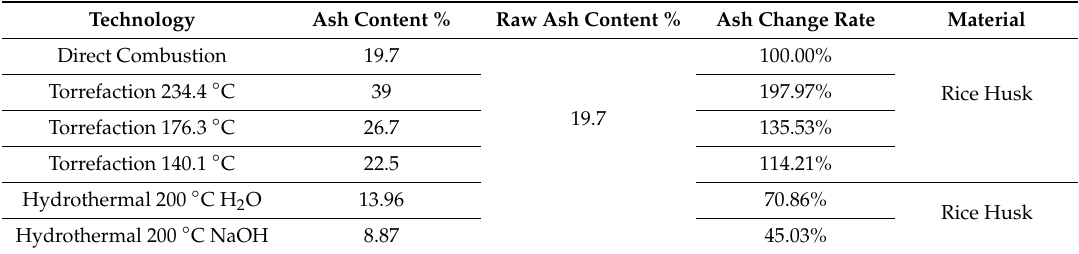
Table 5. Ash content change of di ff erent